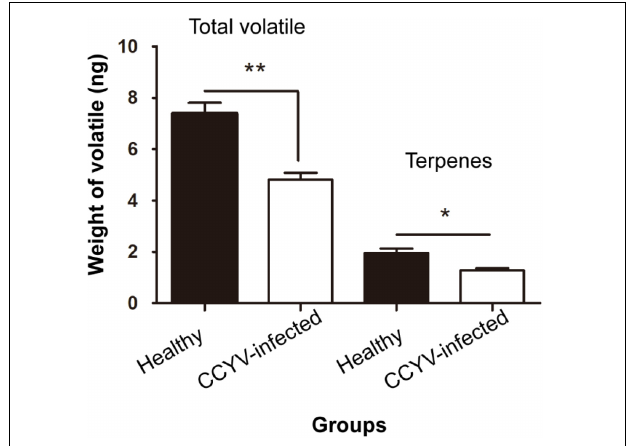
FIGURE 5 | Total amounts of volatiles and terpenes from healthy and CCYV-infected Cucumis sativus seedlings. Columns show mean ± standard error. “*” means p < 0.05, “**” means p < 0.01, the independent-sample t -test was used to calculate the